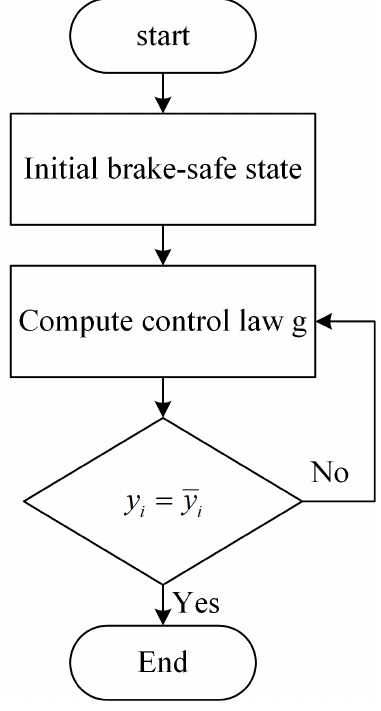
Figure 7. Flow of brake-safe